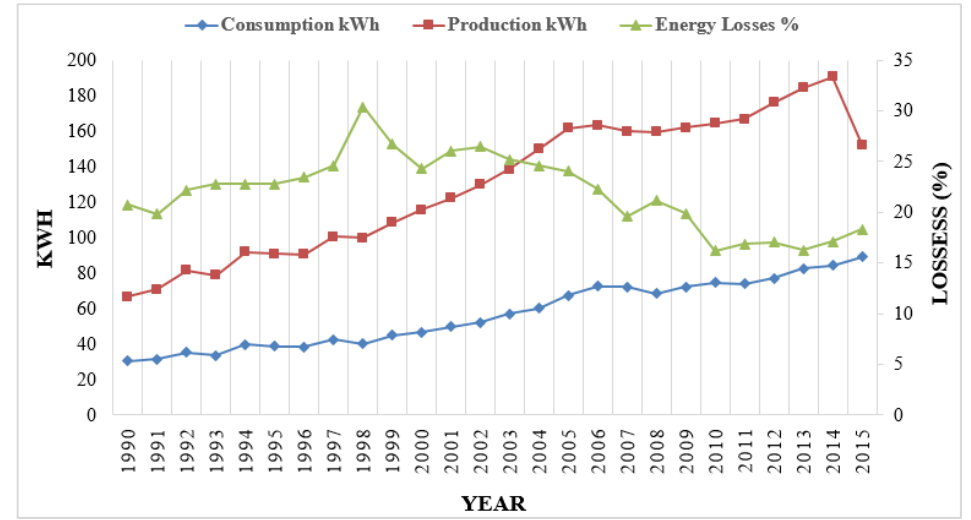
Figure 3. Total electricity generation, consumption and losses (1990–2015).